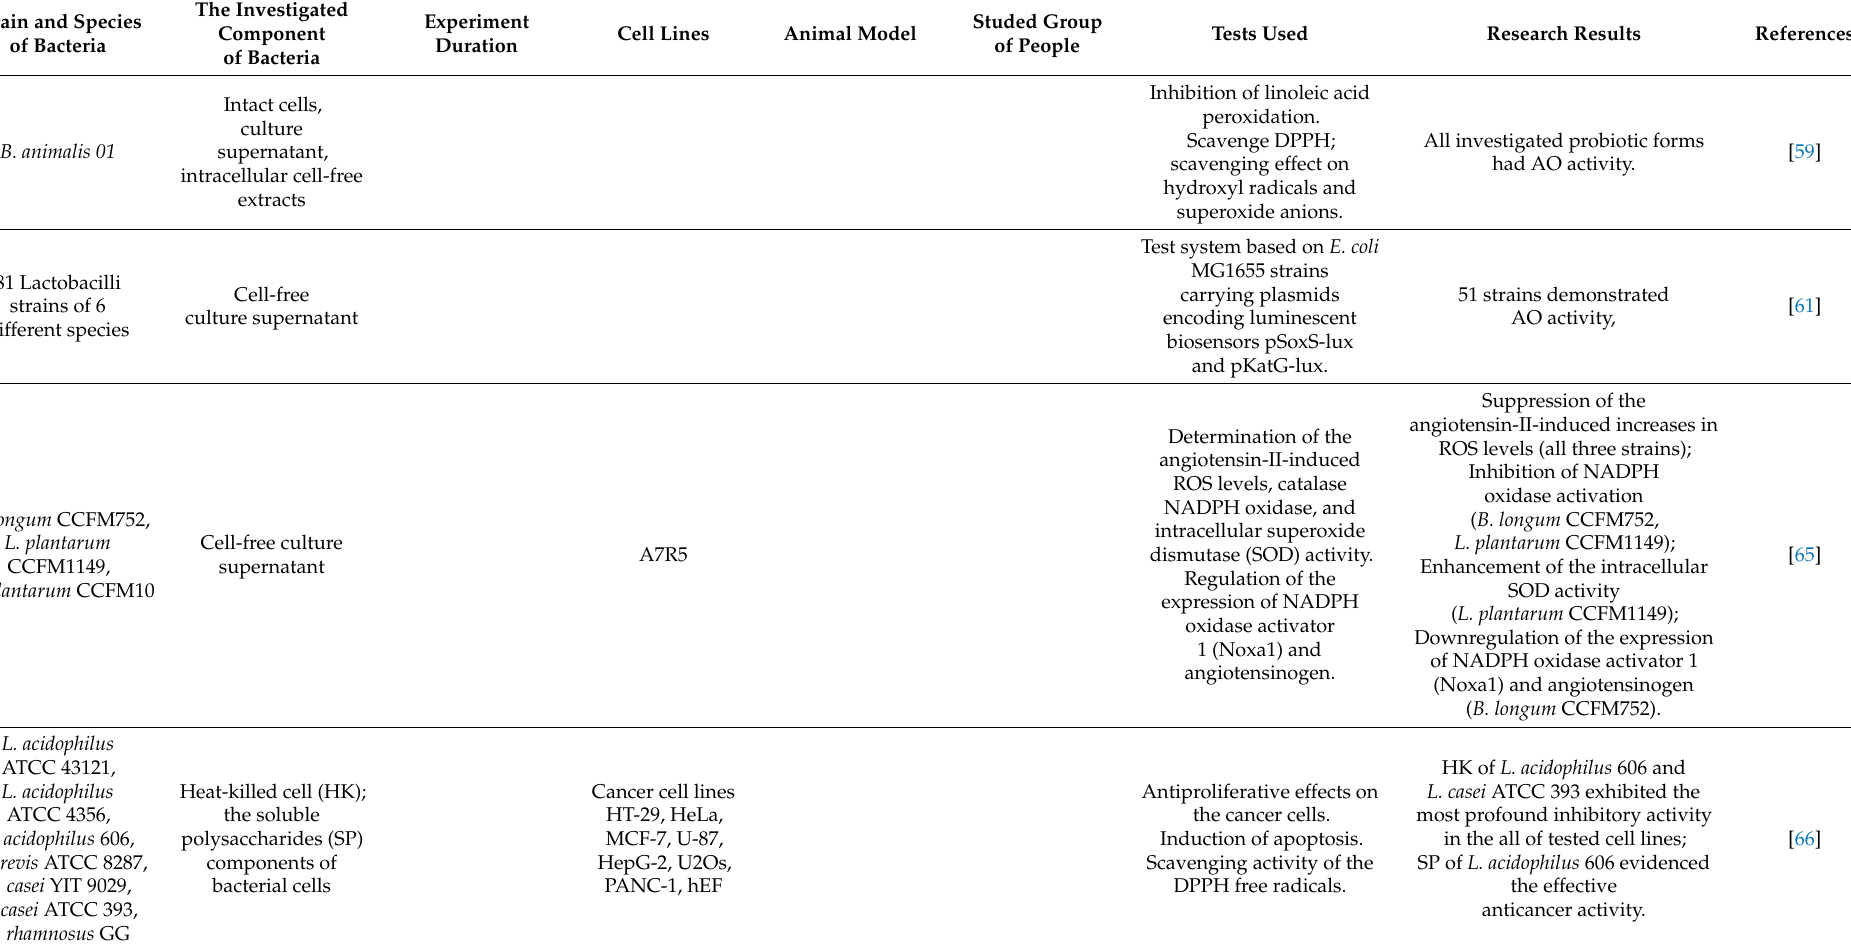
Table 1. Examples of the study of AO activity of lactobacilli and